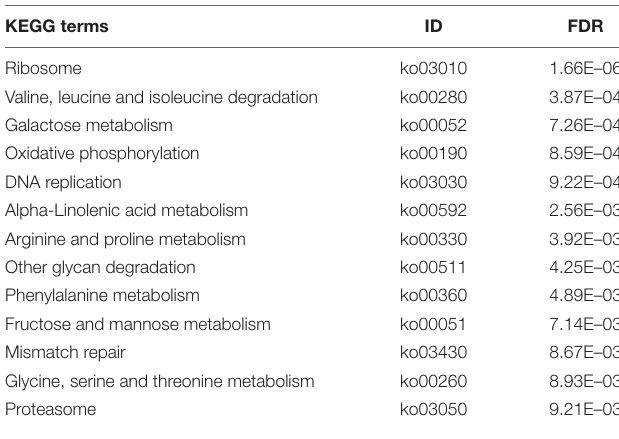
TABLE 5 | List of KEGG pathways significantly enriched by differentially expressed genes in the treatment groups compared to the control groups. FDR = FDR-adjusted p -values. The Benjamini–Hochberg adjustment was used for FDR correction of the p -values (generated by Fisher’s Exact test) of all the KEGG